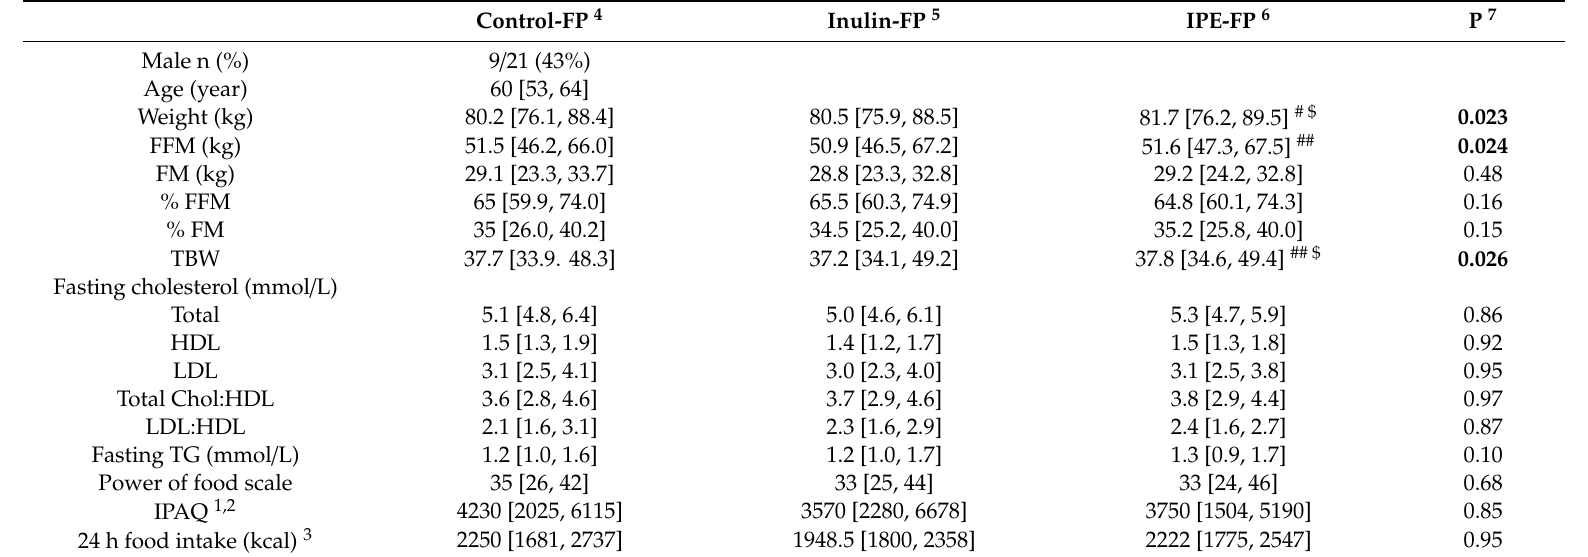
Table 1. Baseline characteristics of subjects and changes in anthropometric measurements and blood lipid profiles between study